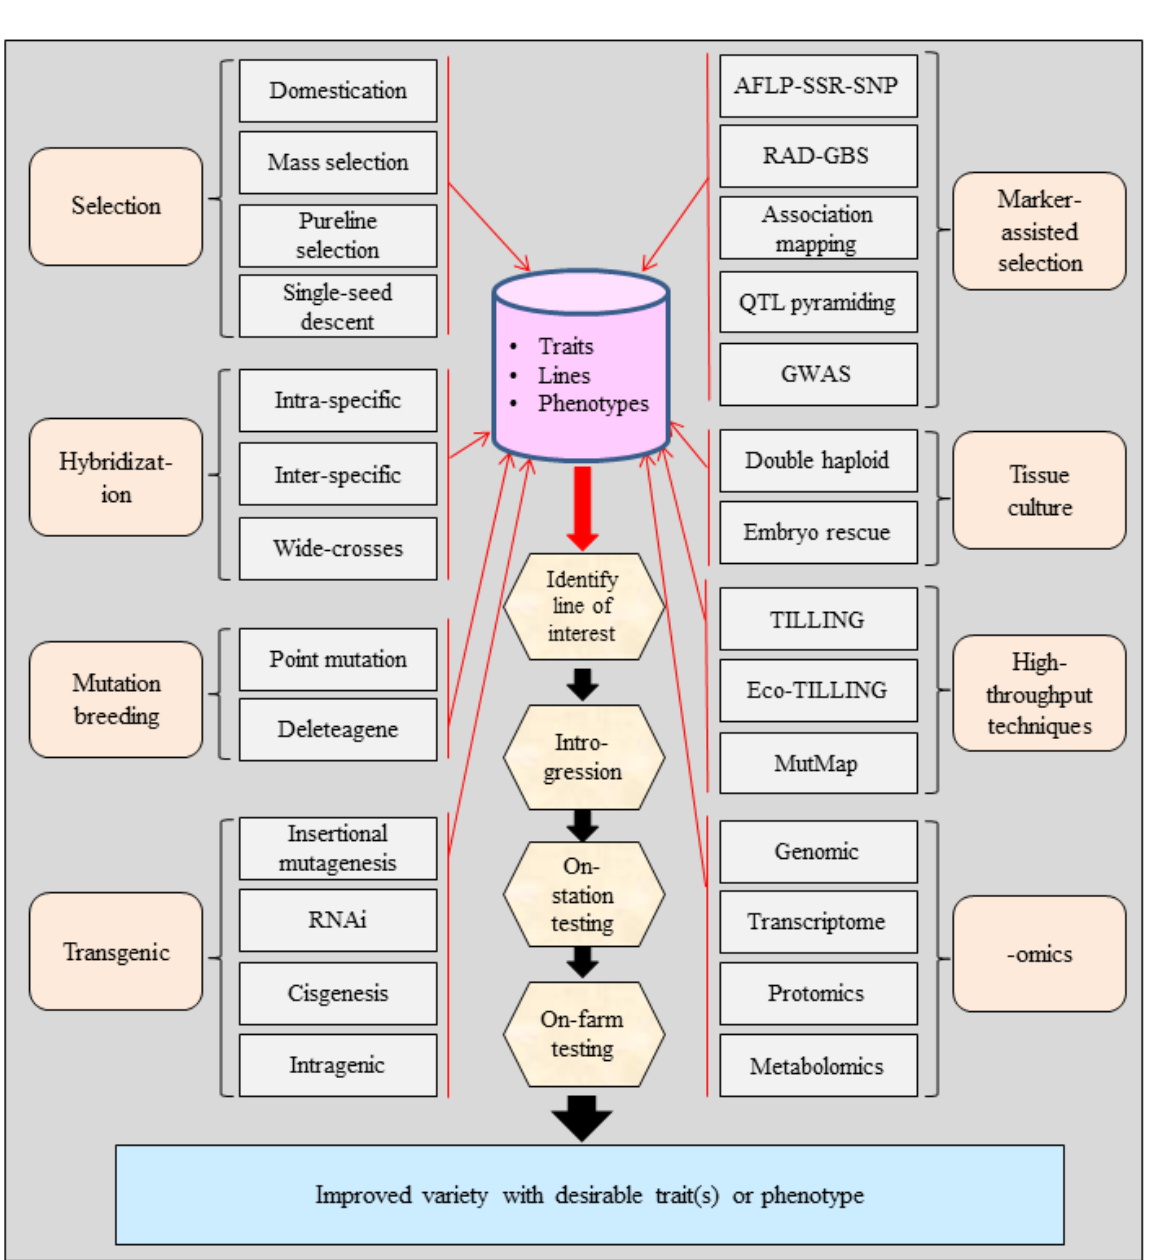
Figure 3. Diverse types of tools implemented in crop improvement. Rounded rectangle : general grouping of improvement methods; rectangle : specialized or specific improvement technique; can: types of products obtained from preliminary screening or breeding; rectangular pentagon: further procedures to be followed before releasing new cultivar(s) to the farming community, which include introgression to locally adapted and/or high-yielding cultivars and multi-location testing at on-station and on-farm